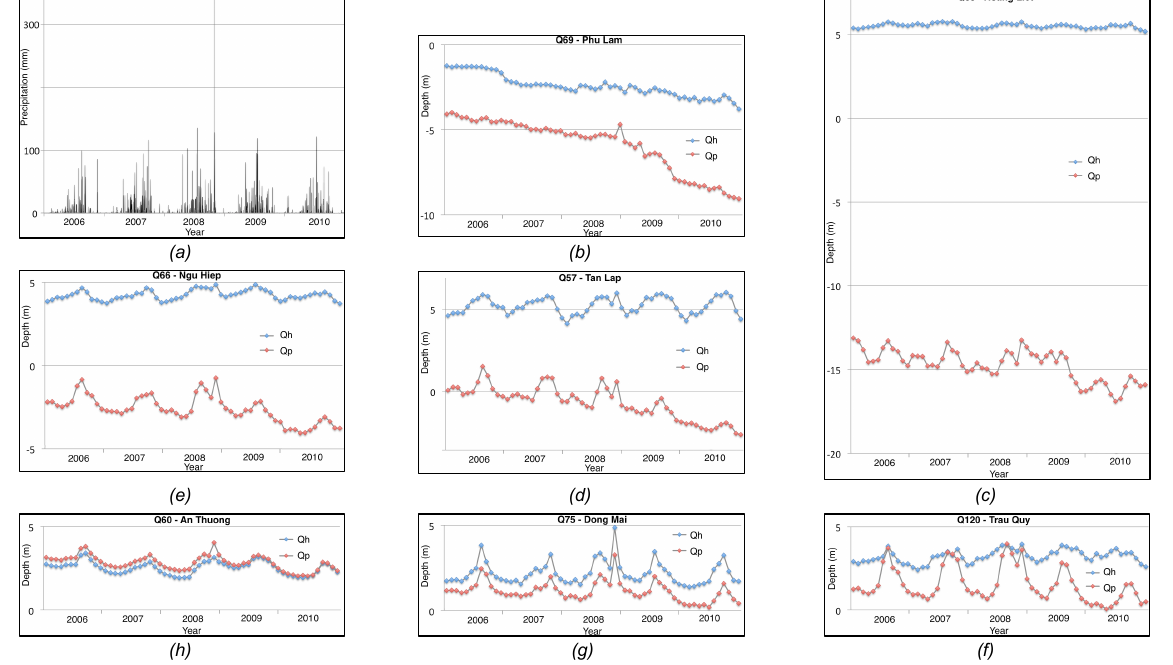
Fig. 12 : ( a ) Precipitation at Lang meteorological station from 2007 to 2010, (after National Hydro-Meteorological Service, 2011). Average groundwater and piezometric level in Qh, Qp during the 2006-2010 period at: ( b ) Q69 at Phu Lam, Ha Dong, ( c ) Q65 Hoang Liet, Hoang Mai, ( d ) Q57 at Tan Lap, Hoai Duc, ( e ) Q66 Ngu Hiep, Thanh Tri, ( f ) Q120 at Trau Quy, Gia Lam, ( g ) Q75 at Dong Mai, Ha Dong, ( h ) Q60 at An Thuong, Hoai Duc, (after Nguyen and Nguyen, 2007, 2008; Nguyen and Pham, 2009, 2010; Nguyen et al., 2011). For location, refer to Fig. 3